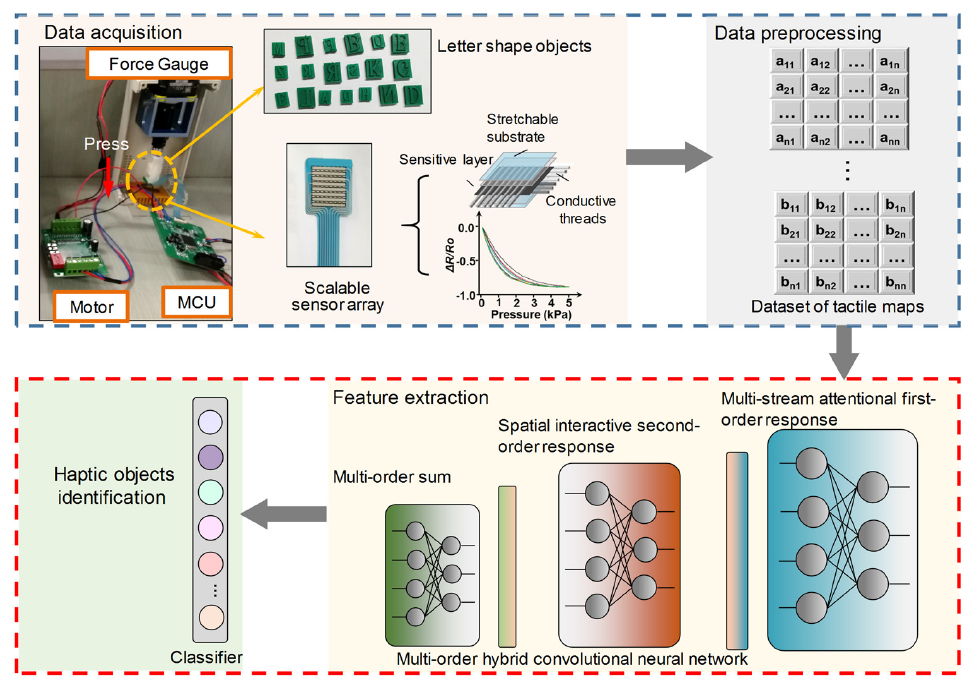
Figure 1. Flowchart of the overall framework.